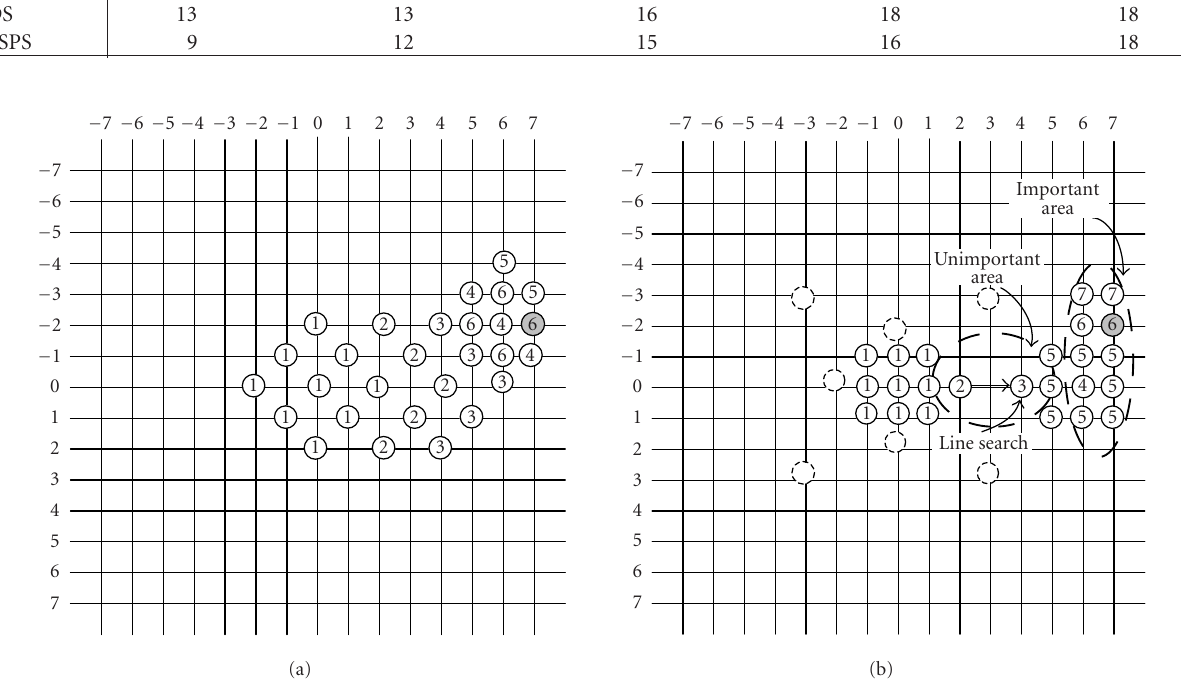
Figure 4: Example of a search path strategy using DS and LSPS to locate a motion vector at (+7, − 2). (a) The search path using DS (28 search points). (b) The search path using LSPS (23 search